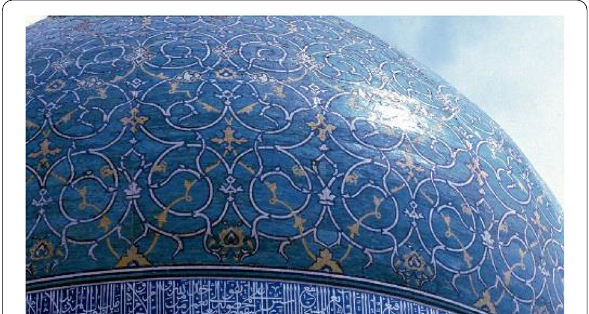
Fig. 2 Exterior of the Dome at the Royal Mosque, Isfahan, Iran (Wade